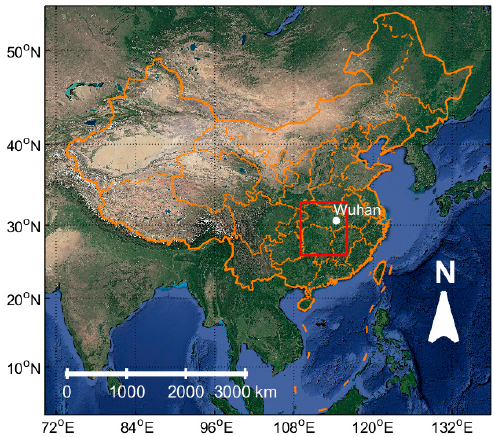
Figure 1. Map of China. The red box represents central China, and the white-filled circle represents Wuhan.